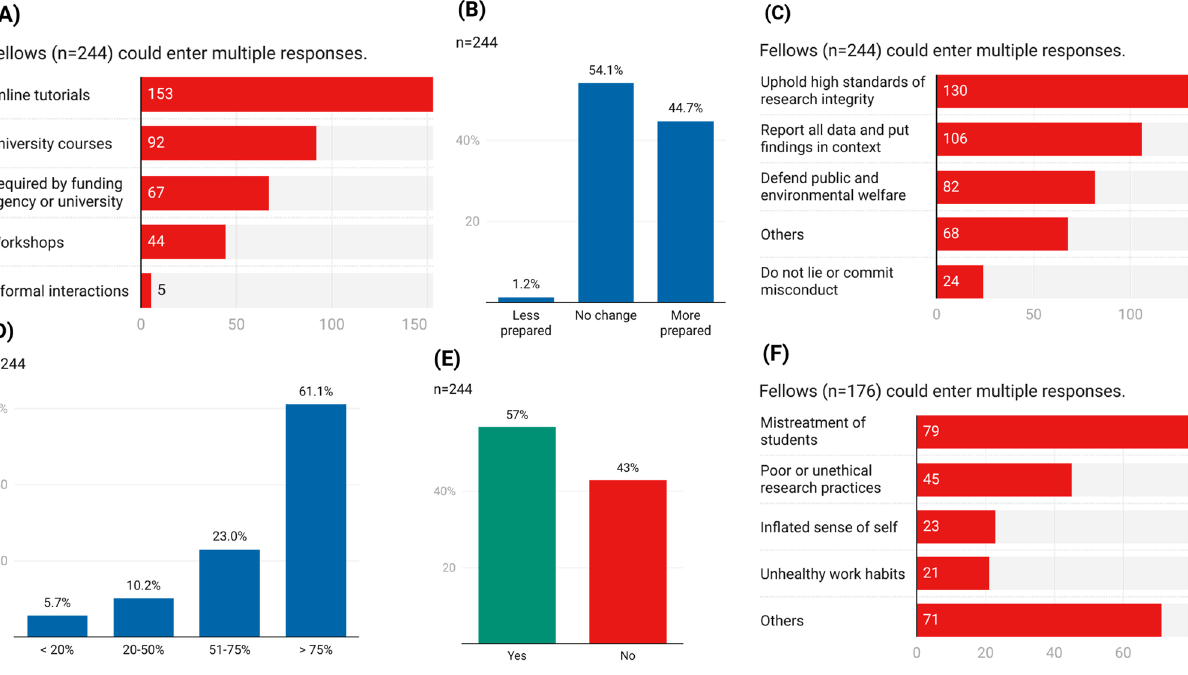
Figure 3. Ethics training and ethical behavior. ( A ) Types of formal ethics training NSF Fellows received. ( B ) Whether these trainings left Fellows prepared to handle ethical issues in graduate school and beyond. ( C